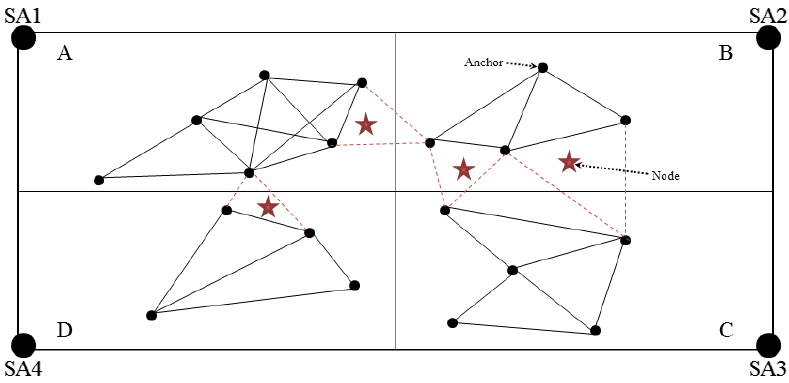
Figure 3. Non-formation of triangles because of residence of anchors in different